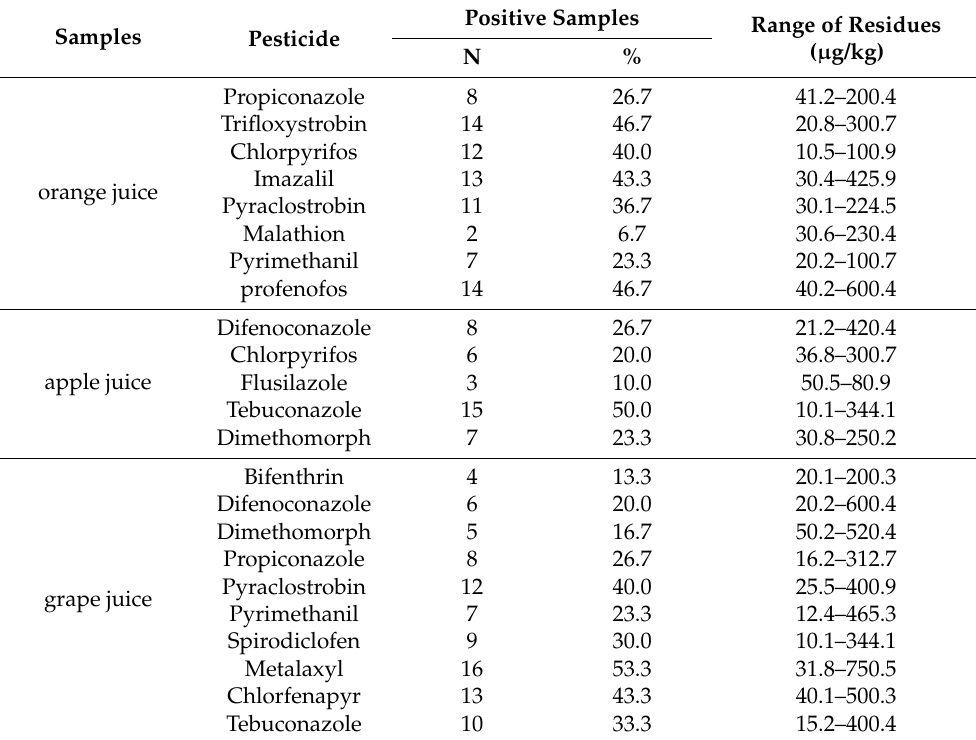
Table 2. Pesticide residues in real vegetable and fruit juice